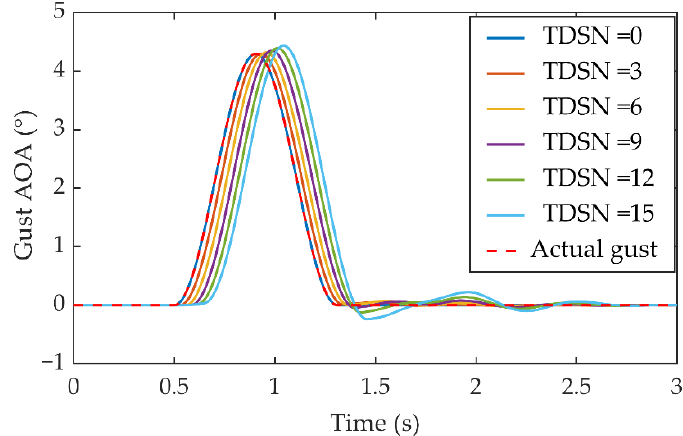
Figure 14. Calculated gust AOA corresponding to different TDSNs of gust sensor.